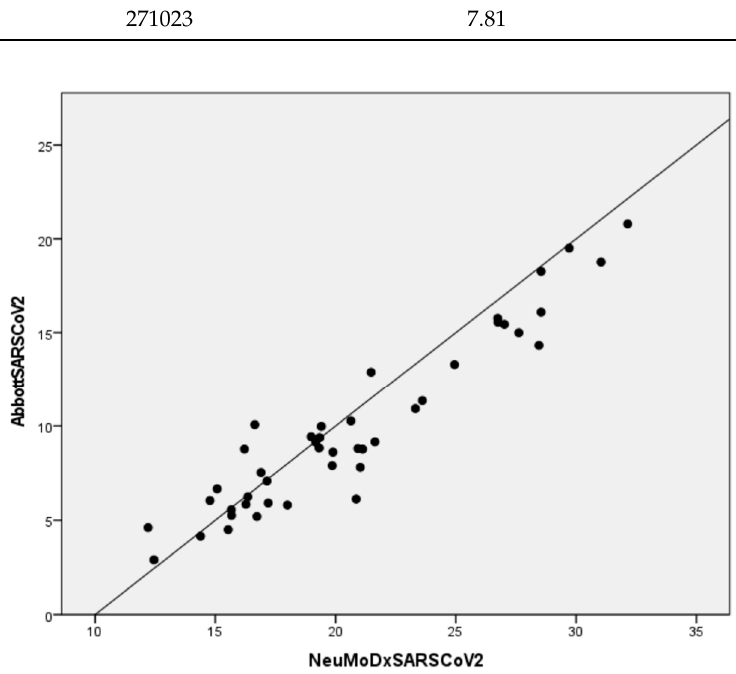
Figure 2. Correlation plots between Abbott RealTime SARS ‐ CoV ‐ 2 and NeuMoDx SARS ‐ CoV ‐ 2